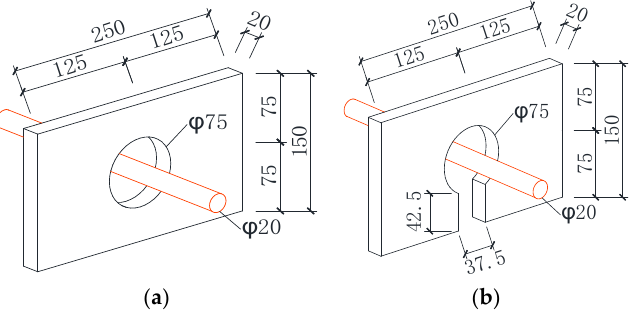
Figure 3. Details of perfobond ribs. ( a ) Conventional perfobond rib; ( b ) notched perfobond